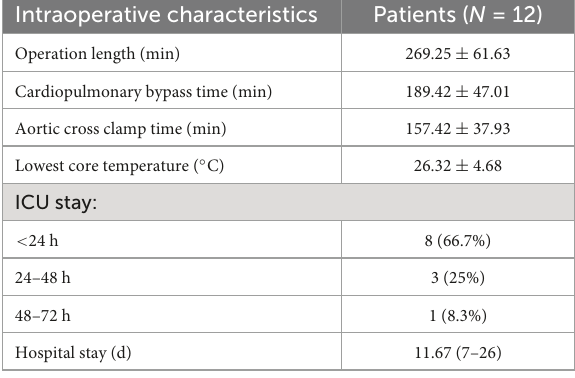
TABLE 2 Peri-operative